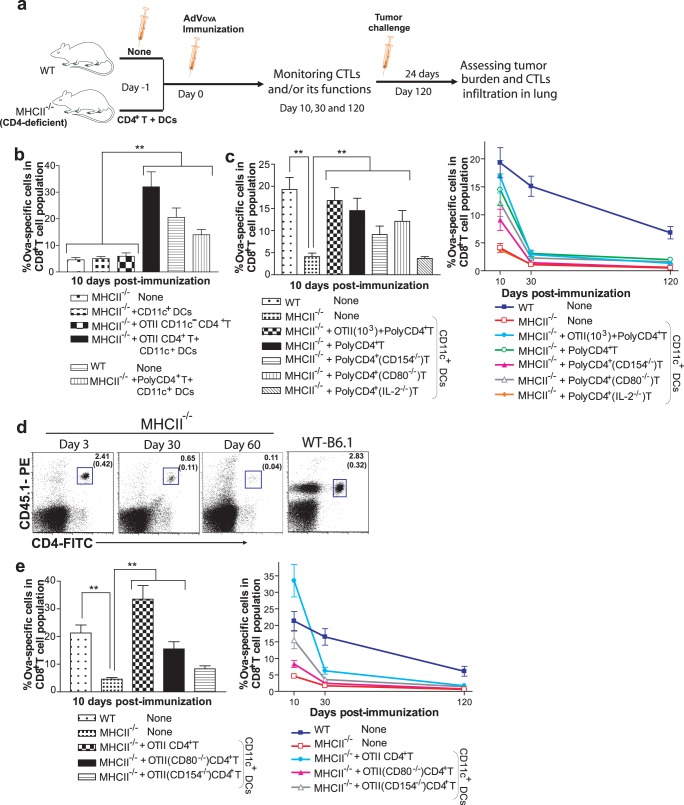
The molecular mechanisms of CD4+ T cell help in CTL primary responses and survival.(a) A schematic protocol. MHCII−/− or WT mice were adoptively transferred with monoclonal (∼1.5×106/mouse) or polyclonal CD4+ T cells (∼15–20×106/mouse) with or without designated gene deficiency and supplied with spleen-derived CD11c+ DCs (∼0.5–1.0×106/mouse). One day later, both MHCII−/− and WT mice were i.v. immunized with AdVova followed by assessment of CTL proliferation in the peripheral blood at the indicated intervals. After 120 days (memory stage) following the immunization, all the groups were challenged with BL6-10OVA tumor cells and assessed for tumor protection. (b) Optimizing CD4+ T cells dose required for CTL expansion in MHCII−/− mice. MHCII−/− mice were transferred with monoclonal (OTII) and/or polyclonal CD4+ T cells and CD11c+ DCs, as shown in the figure. One day later, all the groups were immunized and assessed for CTL proliferation by tetramer assay. The values represent mean %±SD of OVA-specific tetramer+ CTLs in total CD8+ T cell population and are representative of two independent experiments with three to four mice per group. **P<0.01, versus MHCII−/− mice with no adoptive CD4+ T cell transfer. (c) Molecular mechanisms of CD4+ T cell help. MHCII−/− mice were transferred with polyclonal CD4+ T cells with or without designated gene deficiency and CD11c+ DCs as indicated. One day later, all the groups were immunized and subsequently assessed for CTL proliferation by tetramer assay. (d) Poor survival of adoptively transferred naïve CD4+ T cells in MHCII−/− mice. Naïve CD4+ T cells (∼15×106/mouse) on CD45.1+ background were transferred to congenic MHCII−/− mice (CD45.2+) and analyzed 3, 30 and 60 days later by flow cytometry. One representative figure of a group is shown in the dot plot. The values in dot plots represent mean±(SD)% of two independent experiments, each comprising two to three mice per group. (e) Molecular mechanisms of CD4+ T cell help. MHCII−/− mice were transferred with monoclonal (OTII) CD4+ T cells with or without designated gene deficiency and CD11c+ DCs as indicated. One day later, all the groups were immunized and subsequently assessed for CTL proliferation by tetramer assay. In (c) and (e), the values represent mean %±SD of OVA-specific tetramer+ CTLs in total CD8+ T cell population on day 10 post-immunization (left panel) or at the indicated time points (right panel) and are representative of two independent experiments with five to six mice per group. **P<0.01, versus MHCII−/− mice with no adoptive CD4+ T cell transfer.